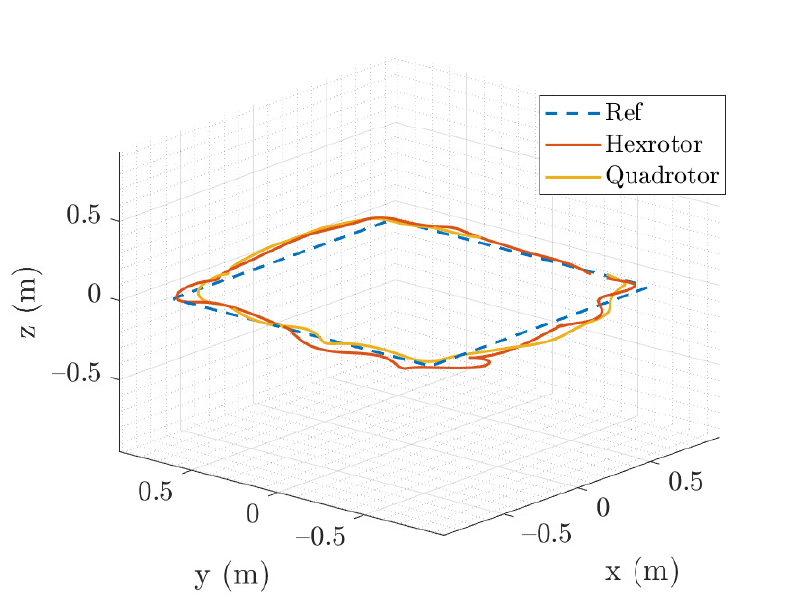
Figure 11. The quadrotor and hexrotor track a 1.5-m-wide square path with waypoint moving in 0.3